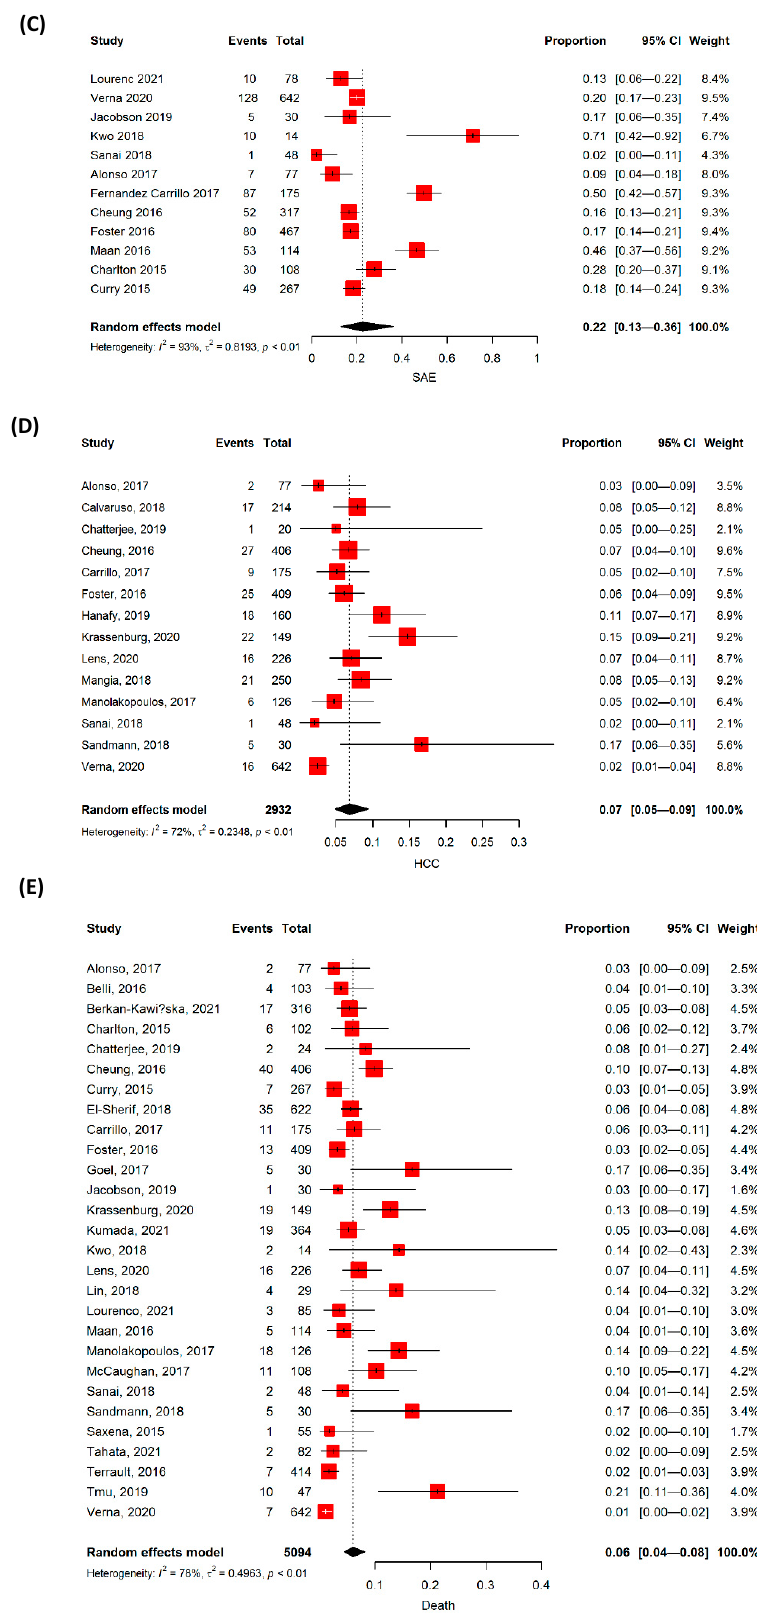
Figure 2. Estimated event rate of ( A ) the sustained virologic response, ( B ) any adverse events, ( C ) serious adverse events, ( D ) development of hepatocellular carcinoma, and ( E ) mortality in decompensated liver cirrhosis patients treated with direct-acting antiviral